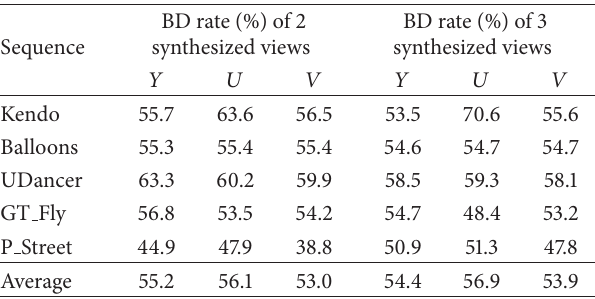
Table 2: BD rate of inter-SDC prediction in multiloop to simulcast encoding.